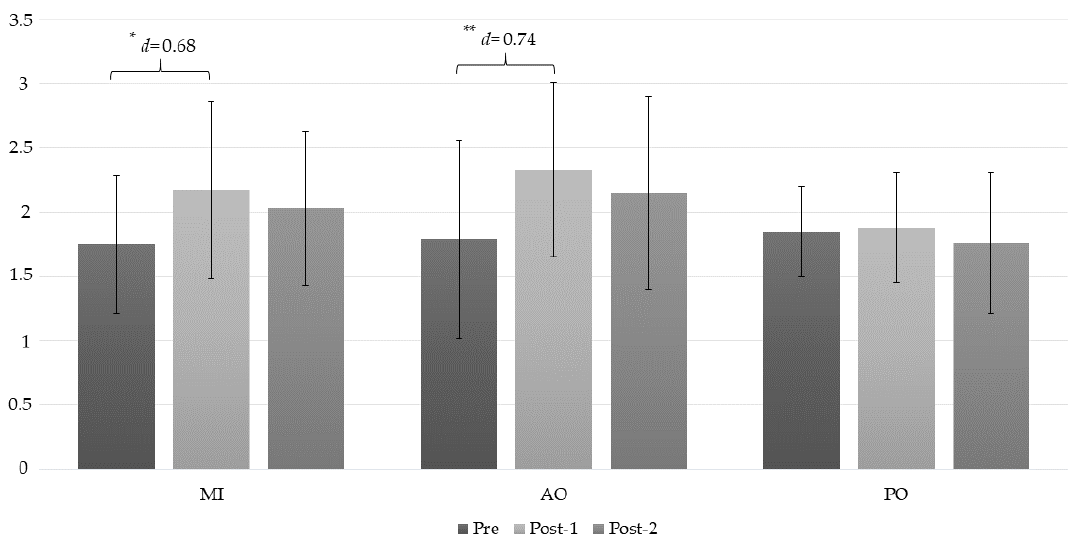
Figure 3. Changes in the pressure pain threshold (PPT) C2 / C3 measurement. *: p < 0.05; **: p < 0.001; AO: action observation; MI: motor imagery group; PO: placebo observation group; Pre: pre-intervention measurement; Post-1: first post intervention measurement (immediately after intervention); Post-2: second post intervention measurement (10 min after intervention). Table 3. Results of the PPT